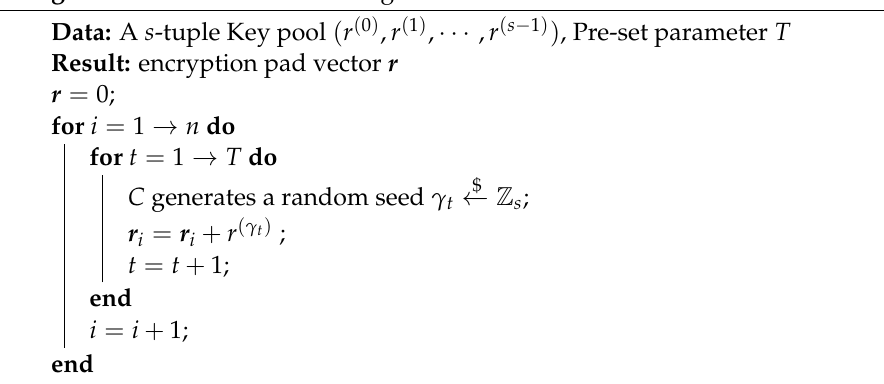
Algorithm 3: Pad-Generation